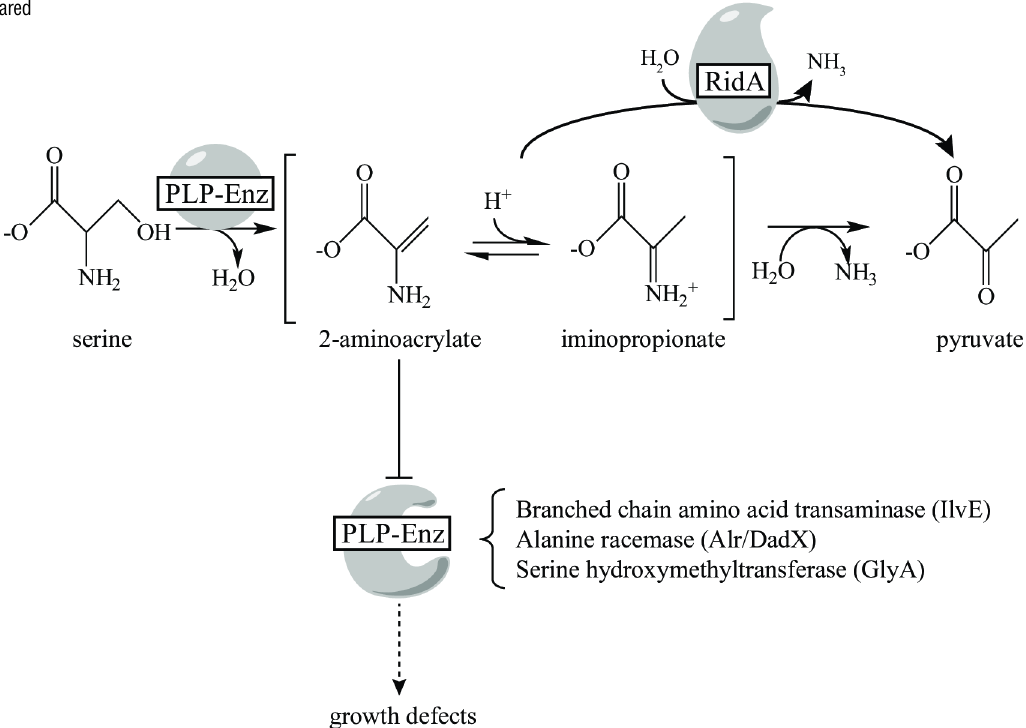
Fig 1. RidA activity in vivo . The PLP-dependent generationof the enamine2 aminoacrylate from serine. Enamine/ imine intermediates(2-aminoacrylate/iminopropionate)are in equilibriumand the latter is hydrolyzedby solvent water or facilitatedby RidA protein, resultingin production of pyruvate. 2AA accumulationin an S . enterica ridA mutant is responsible for the inactivationof particular PLP-enzymes, which leads to growth